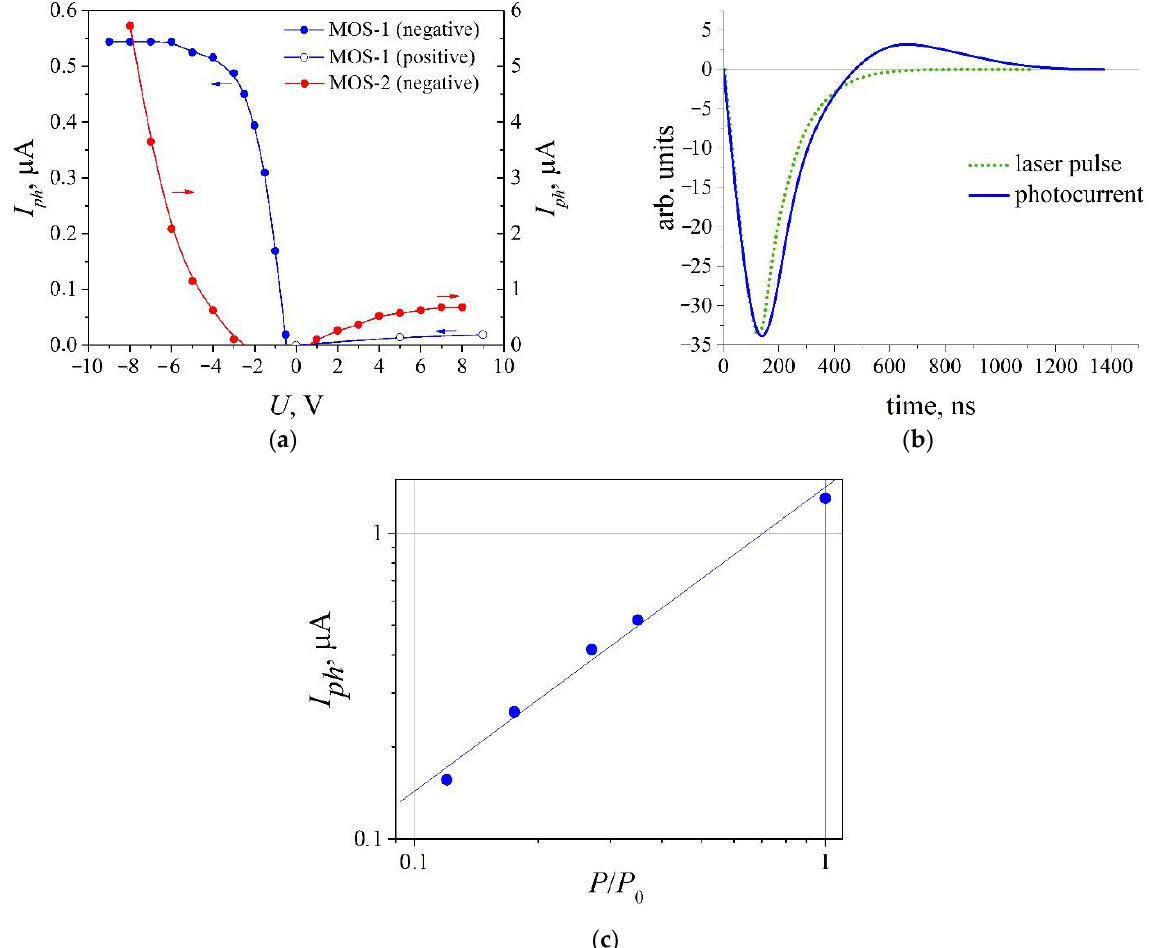
Figure 4. ( a ) Photocurrent versus applied bias voltage. In the legend: “positive” and “negative” indicate photovoltage potential on the load resistor with respect to the ground (see Figure 1). ( b ) Laser pulse (dotted green) and photocurrent pulse (solid blue) through the MOS-1 sample. ( c ) Photocurrent through the MOS-1 sample versus laser intensity ( P 0 = 1.2 MW/cm 2 ) at −2 V bias voltage. The straight line is guide for the eye of linear dependence.